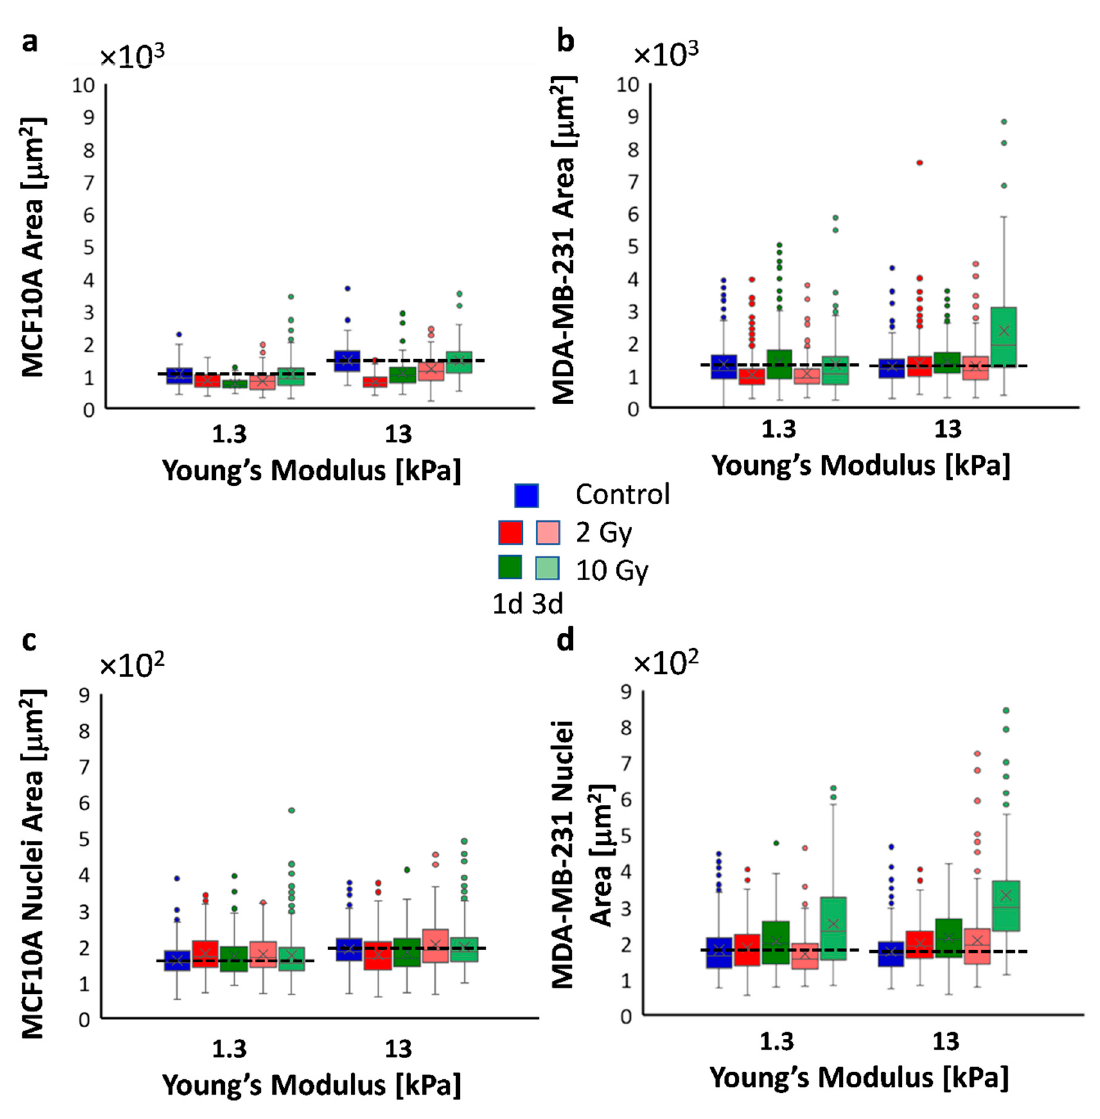
Figure 2. Box plots (mean, median, interquartile range, and outliers) of spreading areas ( a , b ) and nuclei areas ( c , d ). Spreading areas and nuclei area values were obtained from the analysis of Figure 1 and Figure S1). Dashed lines ( a – d ) indicate the mean values of spreading areas and nuclei areas in control conditions. n > 60 for cell spreading data, n > 110 for nuclear data.